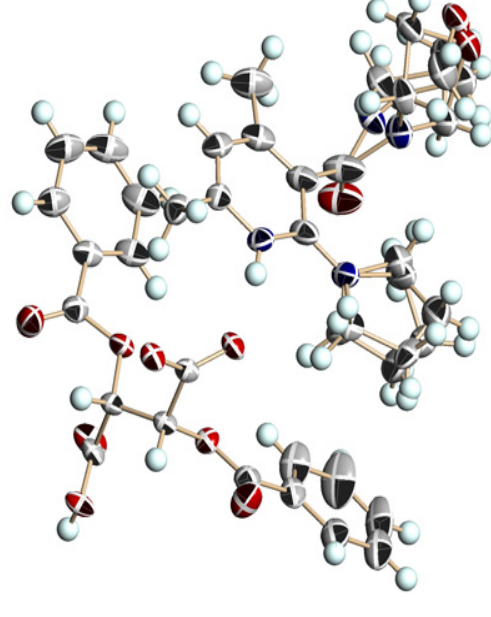
Figure 9. Perspective view of the chiral salt of (a S )- 1c and ( − )- L -DBTA. The ellipsoids are presented as 40% probability. A hydrogen bond between NH (pyridinium ion) and O(O=)C (DBTA) was observed with a distance of 1.95